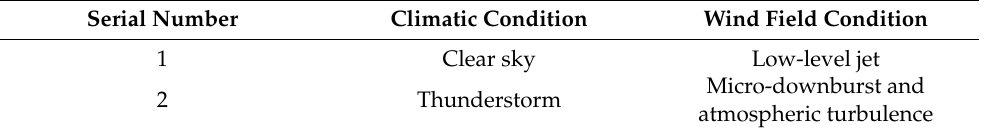
Table 6. Simulation conditions of complex wind